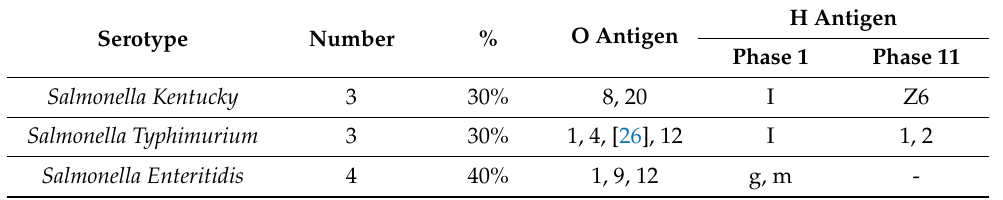
Table 4. Serological identification of S. Enterica